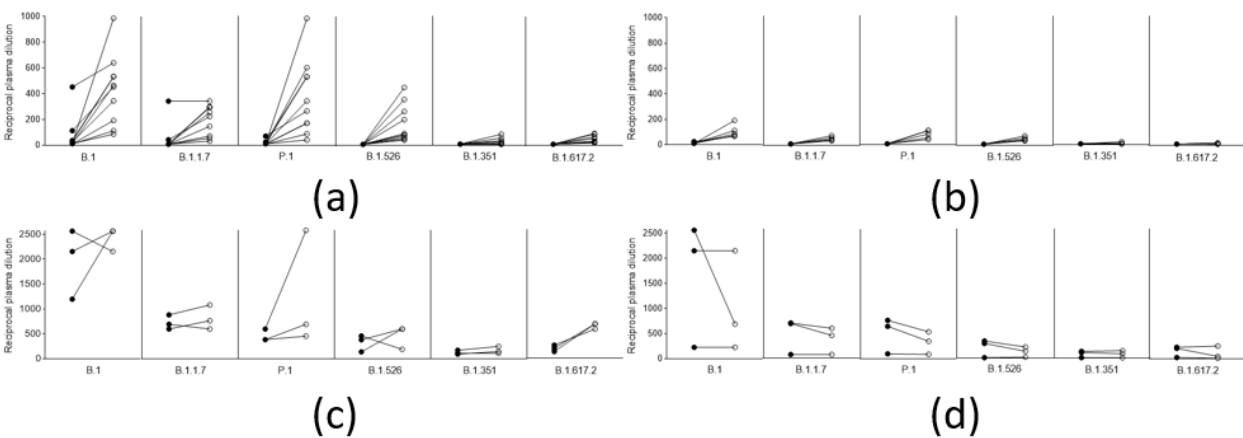
Figure 4. Trend of neutralizing titers against different viral lineages in naive vaccinees and in vaccinees with previous SARS-CoV-2 after a single and a double dose of the respective vaccines. ( a ) Neutralization titers of 10 naïve subjects vaccinated with a single (black circles), and a double dose (white circles), of the BNT162b2 vaccine ( b ) Neutralization titers of 5 naïve subjects vaccinated with a single (black circles), and a double dose (white circles), of the AZD1222 vaccine ( c ) Neutralization titers of 3 subjects vaccinated with a single (black circles), and a double dose (white circles), with the BNT162b2 vaccine after natural infection ( d ) Neutralization titers of 3 subjects vaccinated with a single (black circles), and a double dose (white circles), of the AZD1222 vaccine after natural infection.